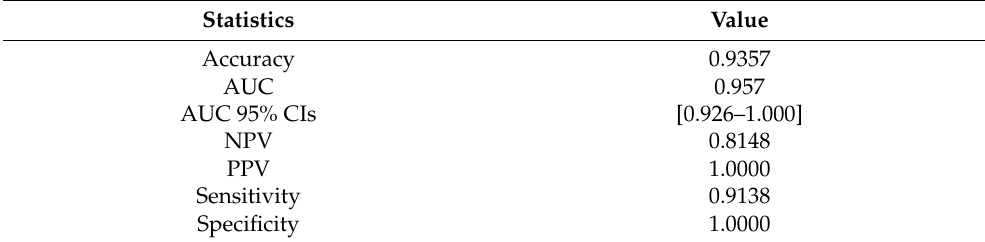
Table 4. Clinical statistics in the diagnosis of the best radiomics pipeline (T2+FLAIR combination).